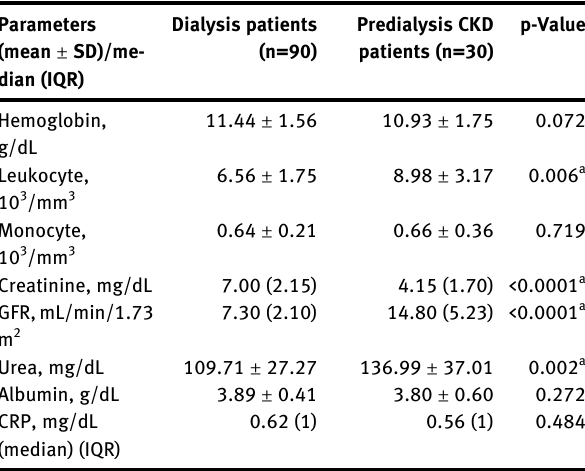
CKD, chronic kidney disease; HD, hemodialysis; HDF, hemodiafiltration; M, male; F, female; DM, diabetes mellitus; PC, post hoc test (Bonferroni). a p<  .  Table  : Laboratory fi ndings of dialysis and predialysis CKD patients.